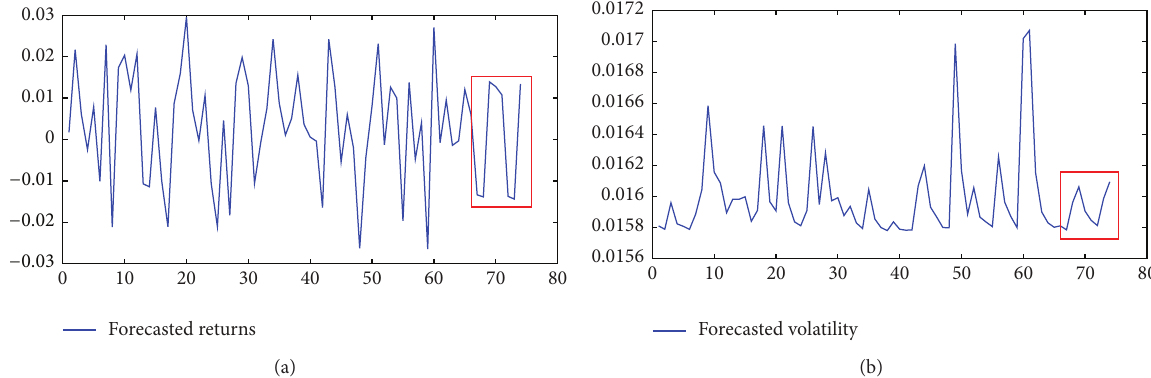
Figure 9: Forecast for returns (a) and conditional standard deviation (b).